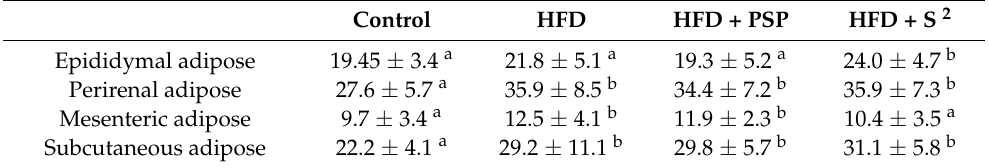
Table 2. Effect of PSP on body lipid in Sprague Dawley rats exposed to HFD 1 .